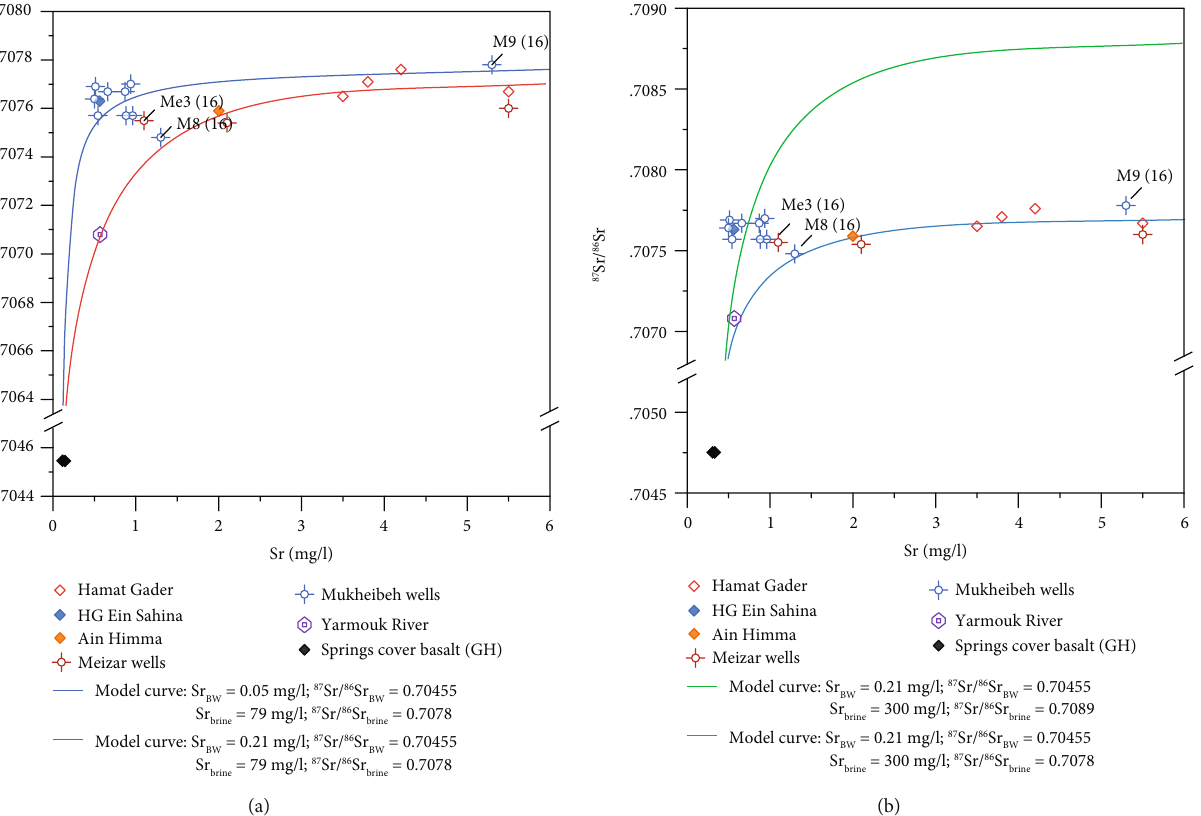
Figure 7: Crossplots of Sr isotope ratios and Sr 2+ in the groundwater from the Lower Yarmouk